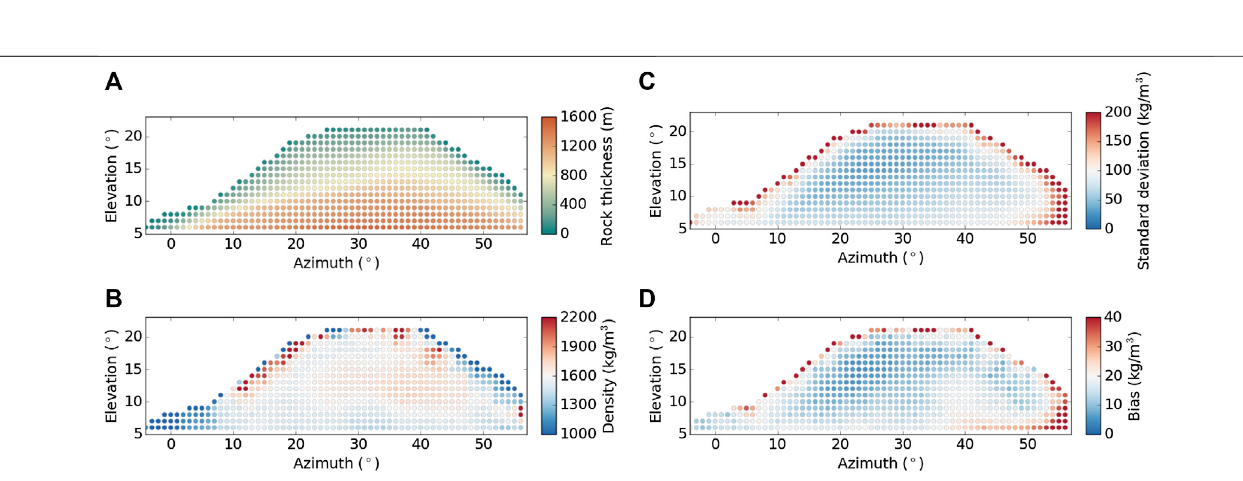
Frontiers in Earth Science |